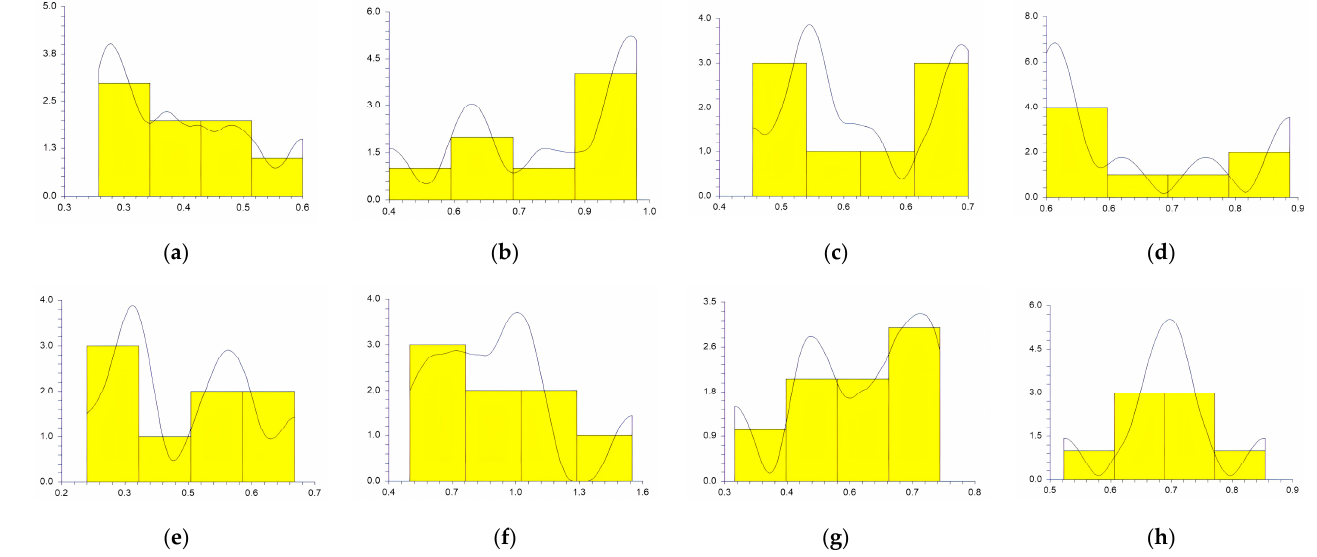
Figure 3. The chamfer width obtained at the reference points by all the participants Monday: ( a ) t1 sitting position; ( b ) t2 sitting position; ( c ) T1 sitting position; ( d ) T2 sitting position; ( e ) t1 supine position; ( f ) t2 supine position; ( g ) T1 supine position; ( h ) and T2 supine position.